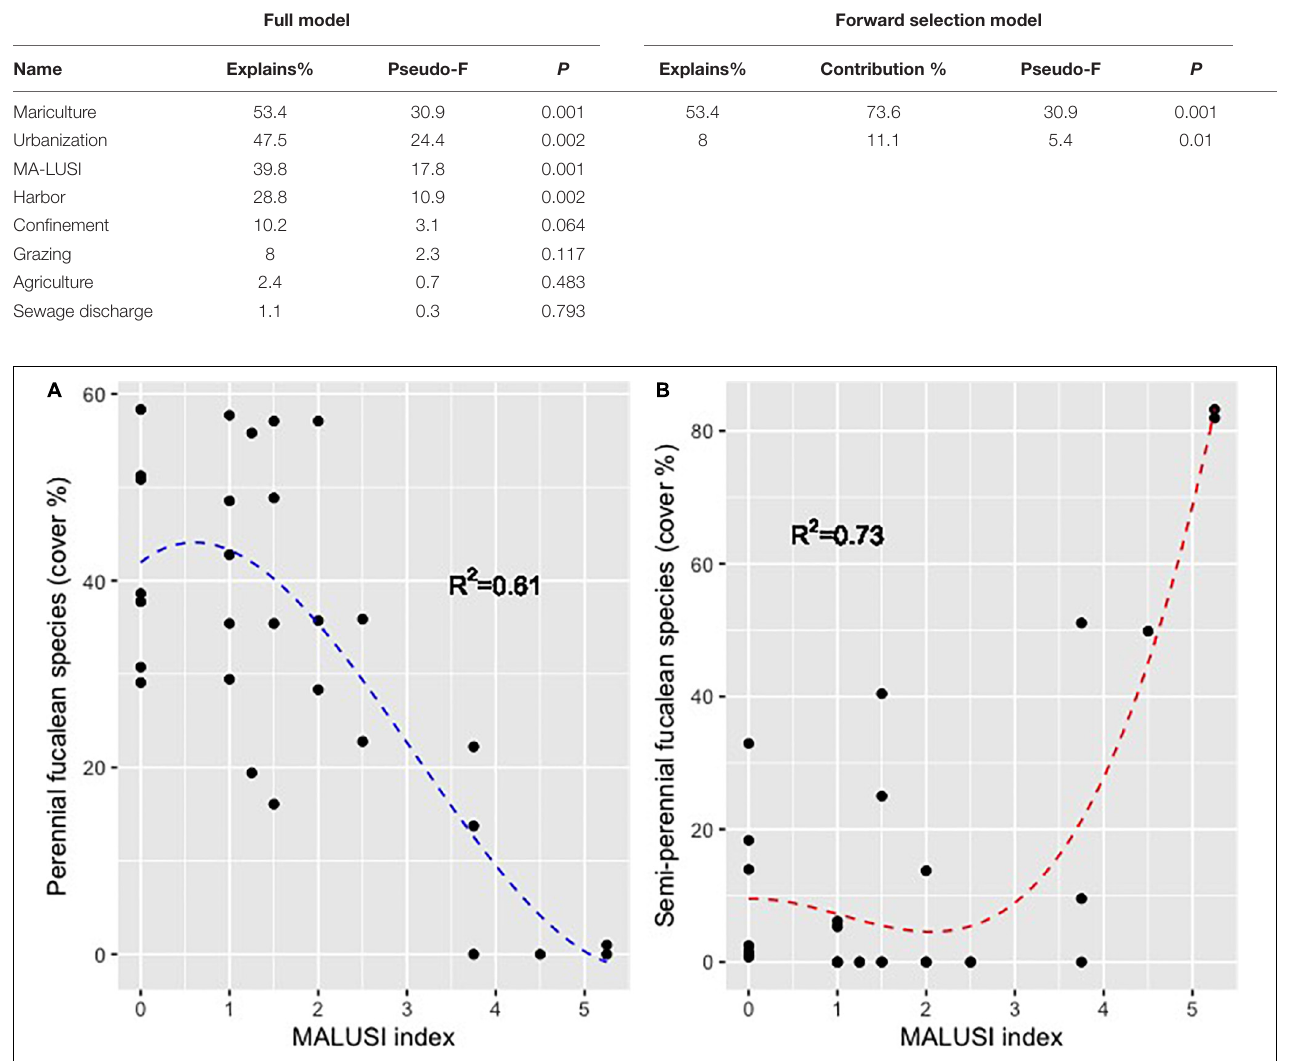
FIGURE 8 | Polynomial regression between MALUSI and (A) percentage cover of perennial fucalean species (y = 0.73x 3 − 6.81x 2 + 7.39x + 41.96) and (B) the semi-perennial species Cystoseira compressa, C. compressa var. pustulata (y = 1.24x 3 − 3.93x 2 + 0.4x +